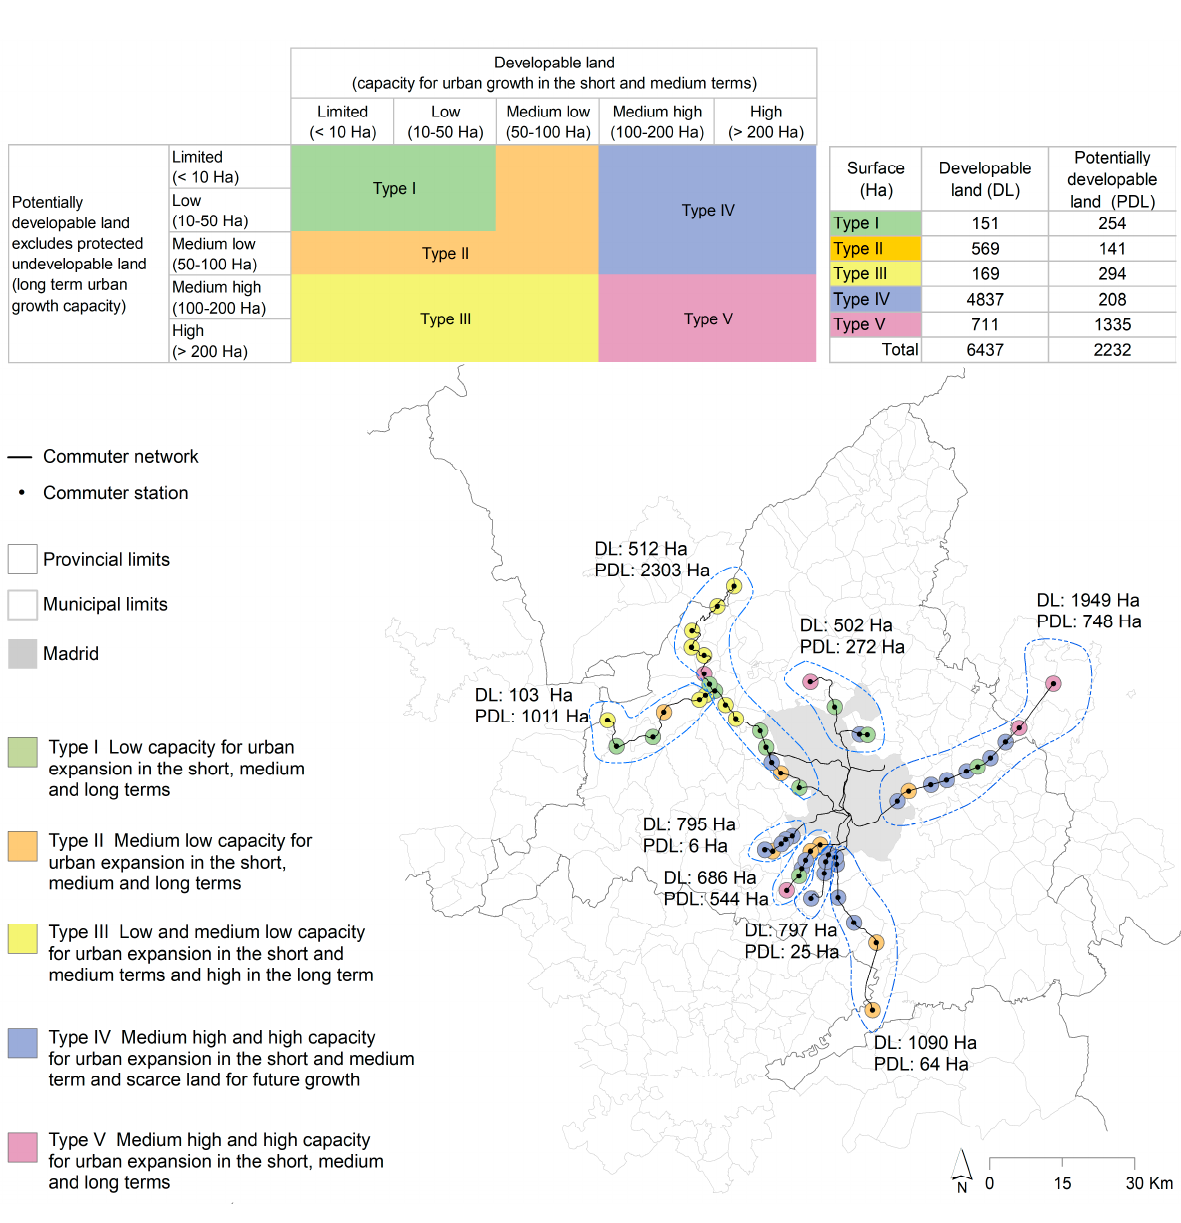
Figure 4. Types of station areas based on their capacity for urban expansion in the short, medium, and long terms.